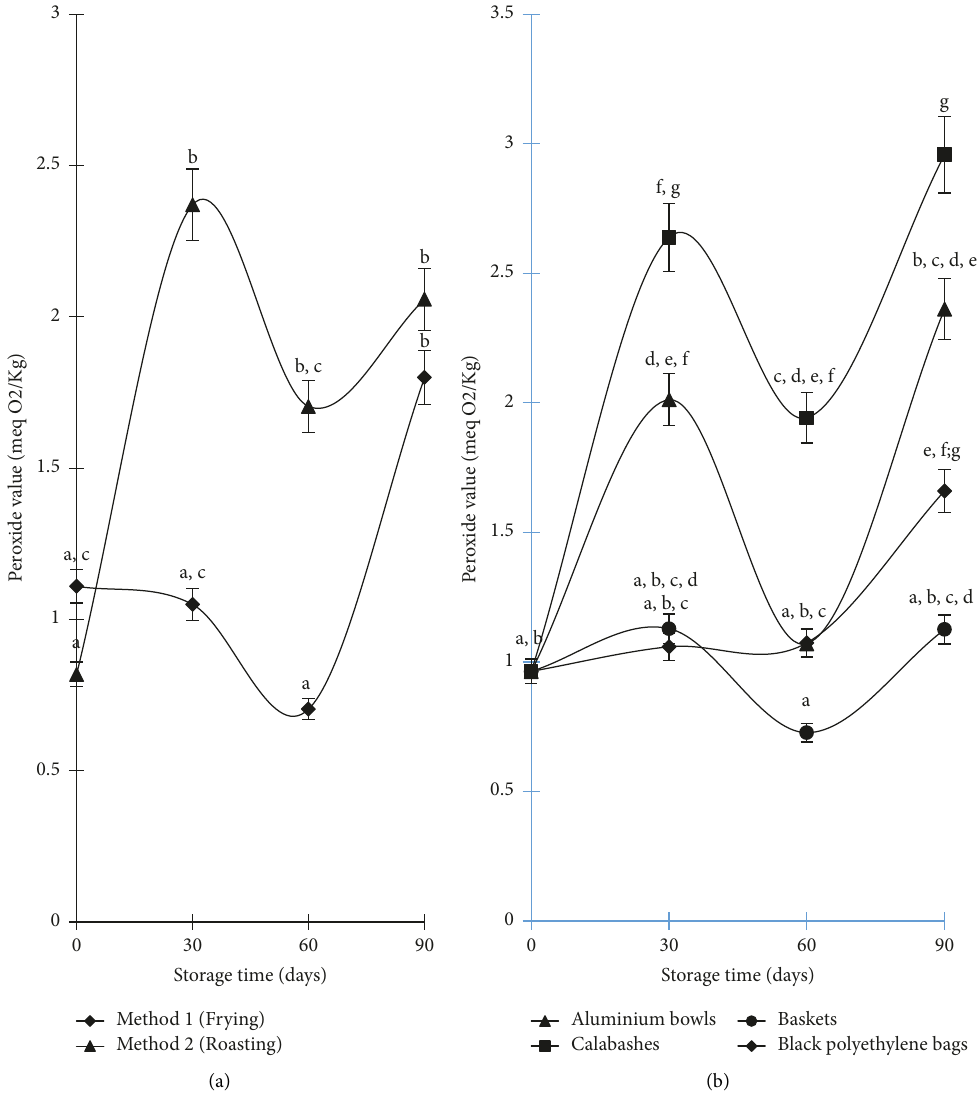
Figure 4: Effect of the production method (a) ( n � 12) and packaging material (b) ( n � 6) on the peroxide value of Pentadesma butter during